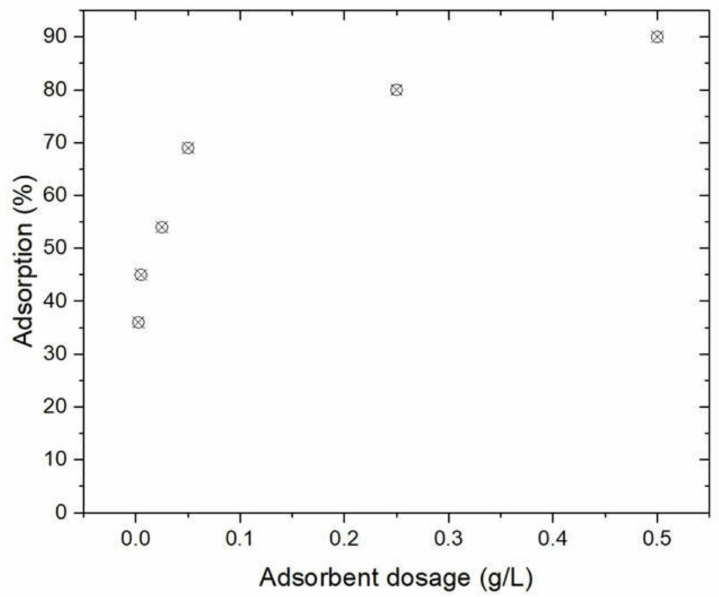
Figure 6. E ff ect of the adsorbent dosage on the Cr(VI) adsorption process. Aqueous phase: 0.01 g / L Cr(VI) at pH 3. Temperature: 20 ◦ C Time: 5 h. Stirring speed: 1000 min − 1